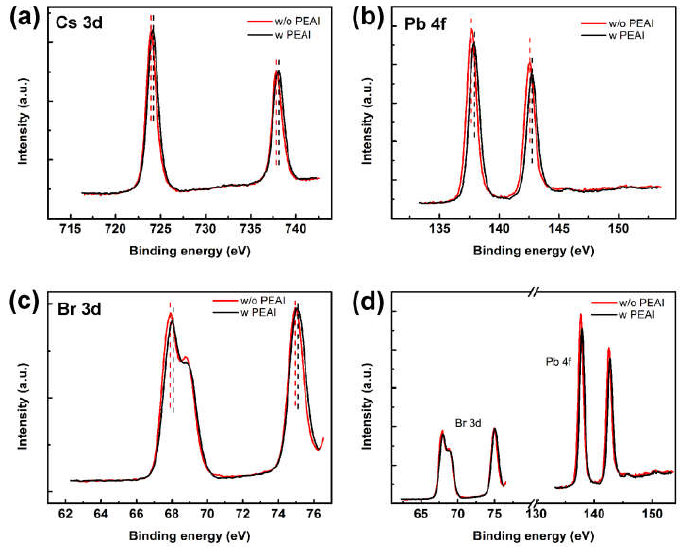
Figure 3. High-resolution XPS spectra of ( a ) Cs 3d, ( b ) Pb 4f, and ( c ) Br 3d. Pb 4f and Br 3d core-energy-level spectra are compared in ( d ).